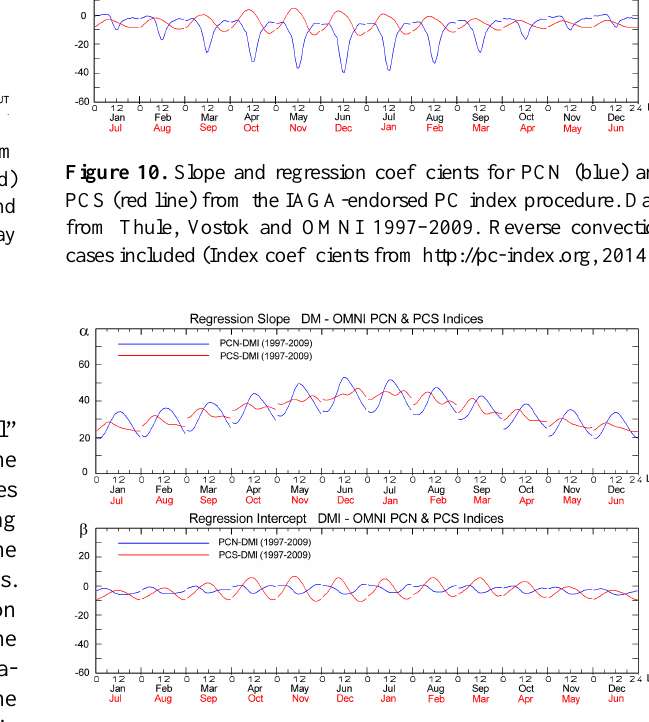
Figure 11. Slope and regression coefficients for PCN (blue) and PCS (red line) derived with DMI procedure. Data from Thule, Vos- tok, and OMNI 1997–2009 (ex. 2003). Strong reverse convection cases